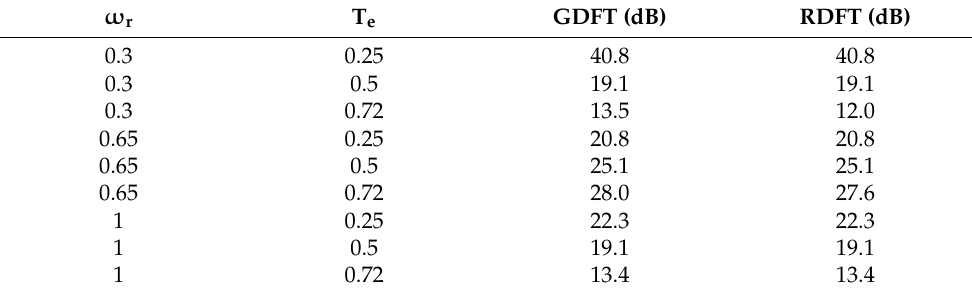
Table 1. Amplitudes of the rotor-fault-related harmonic at scalar control of rotor with 3 broken bars.